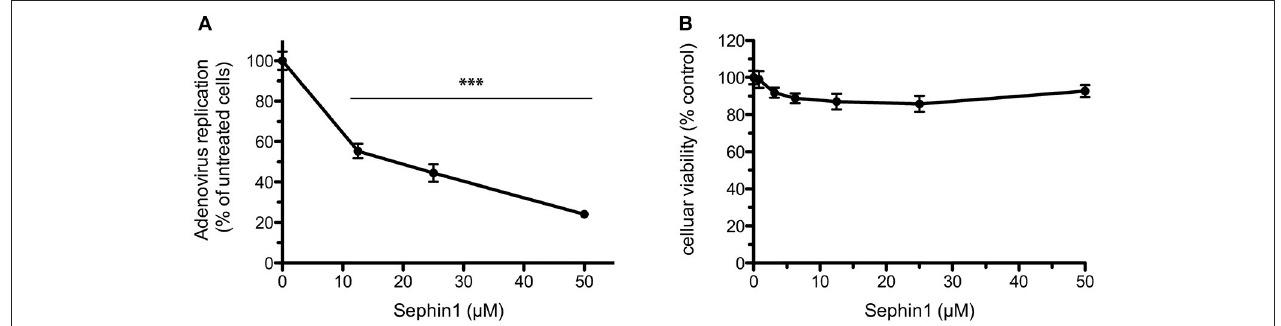
FIGURE 7 | Evaluation of the antiviral properties of Sephin1 against human Adenovirus. (A) HEK293 cells were infected with a recombinant strain of hAdV expressing ANCHOR3 and incubated with increasing doses of Sephin1 or DMSO alone. After 24h, virus replication was determined by automated counting of GFP foci. (B) Viability of HEK293 cells incubated with increasing doses of Sephin1 or DMSO alone was determined after 24h incubation using the cellular viability assay Vita-Blue. Data represent mean ± SEM from representative experiments, repeated at least three times. *** p < 0.001 by one-way analysis of variance, followed by Bonferroni comparison test comparing the Sephin1-treated groups at the indicated concentrations to the vehicle-treated control